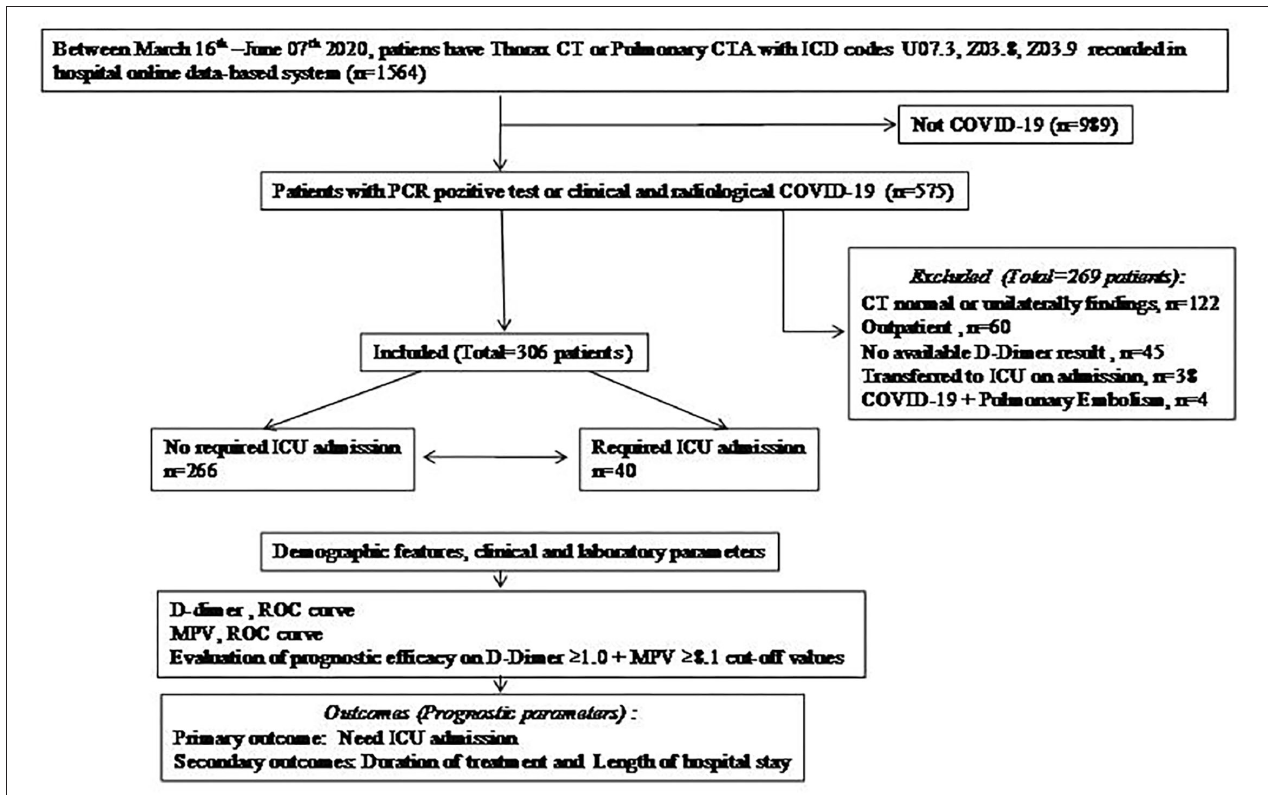
FIGURE 1 | Flow chart. COVID-19, Coronavirus disease-19; CT, computed tomography; CTA, computed tomography angiography; ICU, intensive care unit; MPV, mean platelet volume; PCR, polymerase chain reaction; ROC, receiver operating